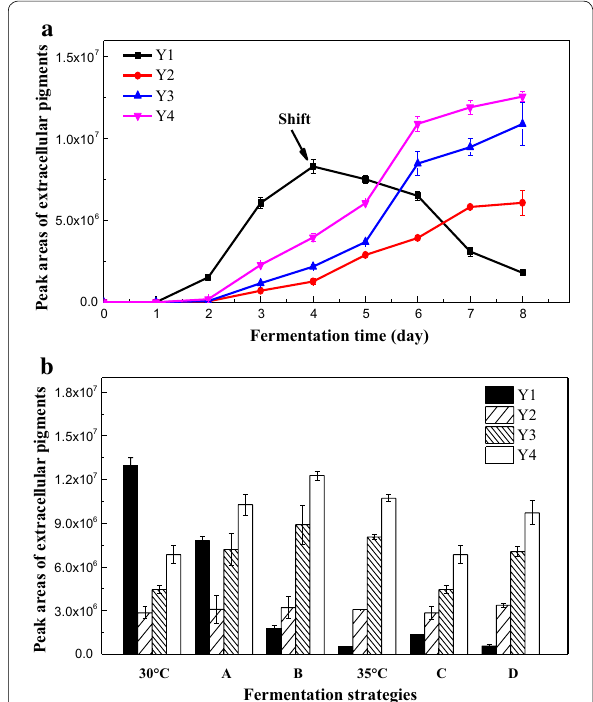
Fig. 4 Temperature-shift strategy fermentation on the production of extracellular four water-soluble yellow pigments. a Time course of the four new water-soluble yellow pigments fermentation under B strategy. b Yields of the four water-soluble yellow pigments under dif- ferent fermentation strategies. Fermentation strategies: 30 and 35 °C respectively represented fermentation at 30 and 35 °C for 8 days; A 30 °C for 6 days and then turn into 35 °C for 2 days; B 30 °C for 4 days and then turn into 35 °C for 4 days; C 35 °C for 4 days and then turn into 30 °C for 4 days; D 35 °C for 6 days and then turn into 35 °C for 2 days